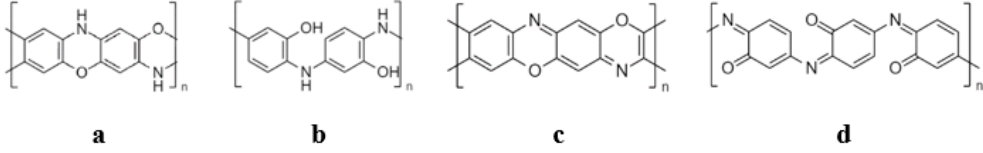
Figure 2. Various PoAP structures: ( a ) ladder-like. ( b ) open-chain. ( c ) quinoid structure. ( d ) keto form.